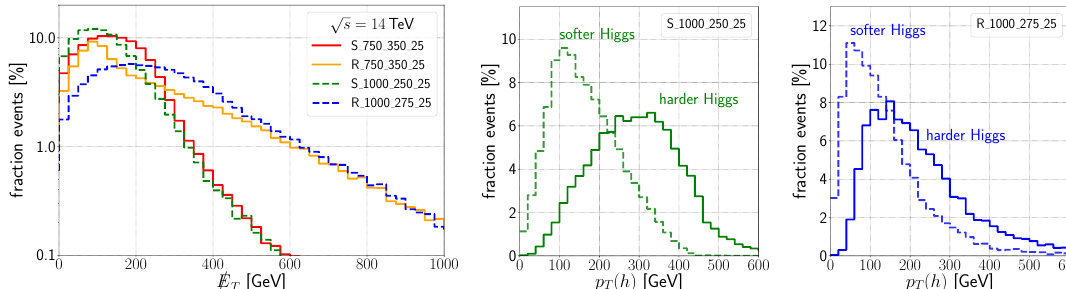
Figure 2 . Left panel: reconstructed =E distribution for four benchmarks. Solid lines correspond T to a compressed spectrum, S 750 350 25 (red) and R 750 350 25 (orange); dashed lines represent a split spectrum, S 1000 250 25 (green) and R 1000 275 25 (blue). Center and right panels: trans- verse momentum distribution of the harder (solid) and the softer (dashed) Higgs bosons at the parton level, for the benchmarks S 1000 250 25 (center panel) and R 1000 275 25 (right